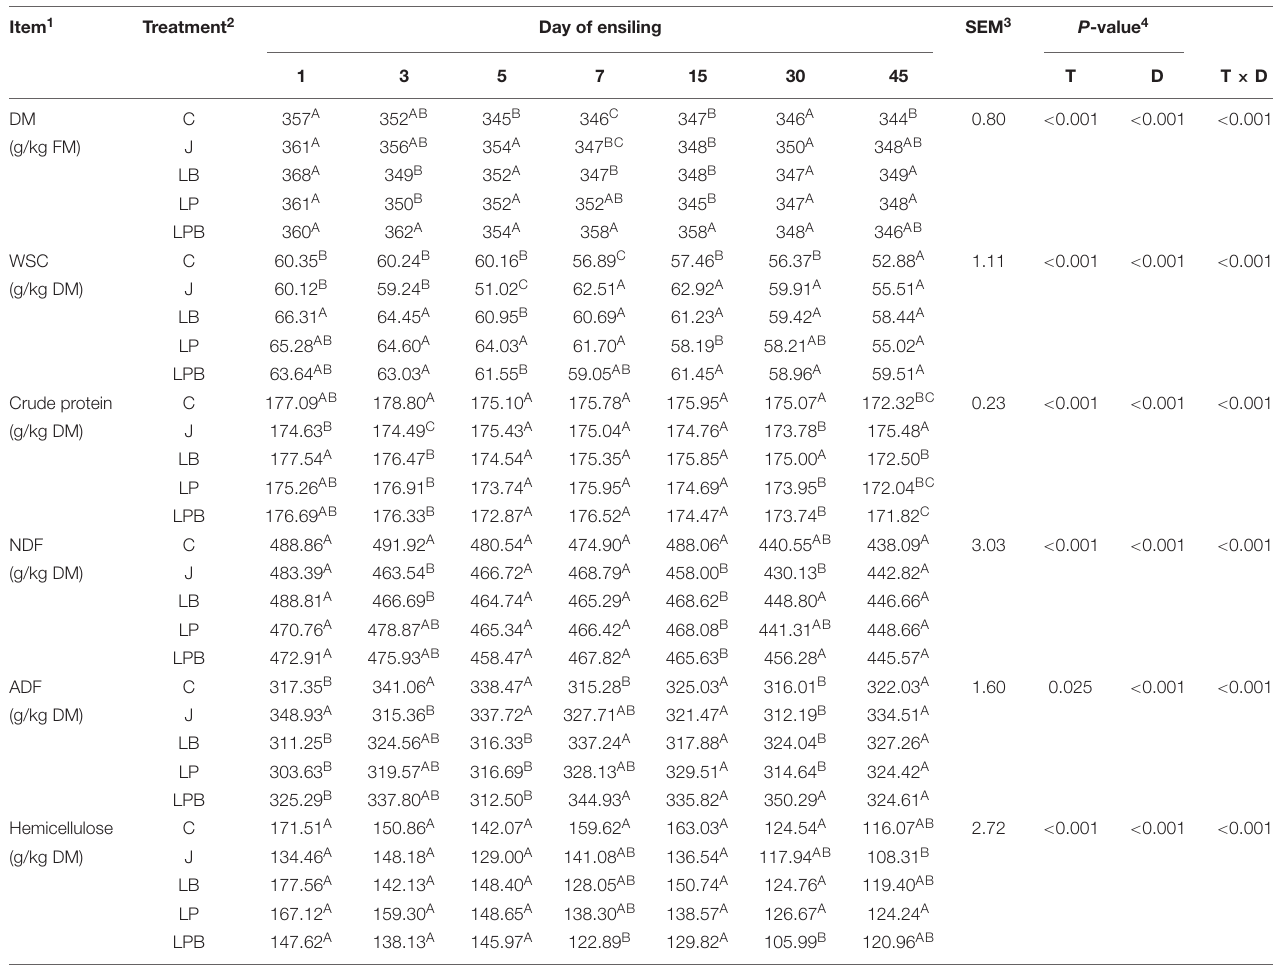
TABLE 3 | Effects of additives on chemical compositions of